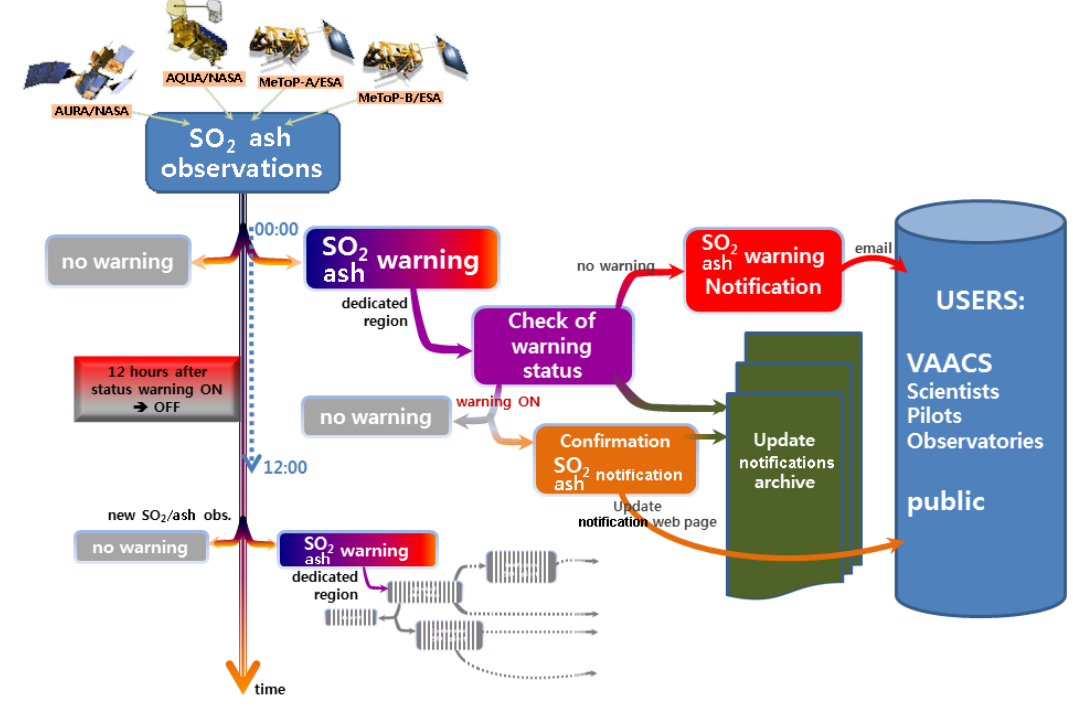
Fig. 8. Overview of the SACS notification